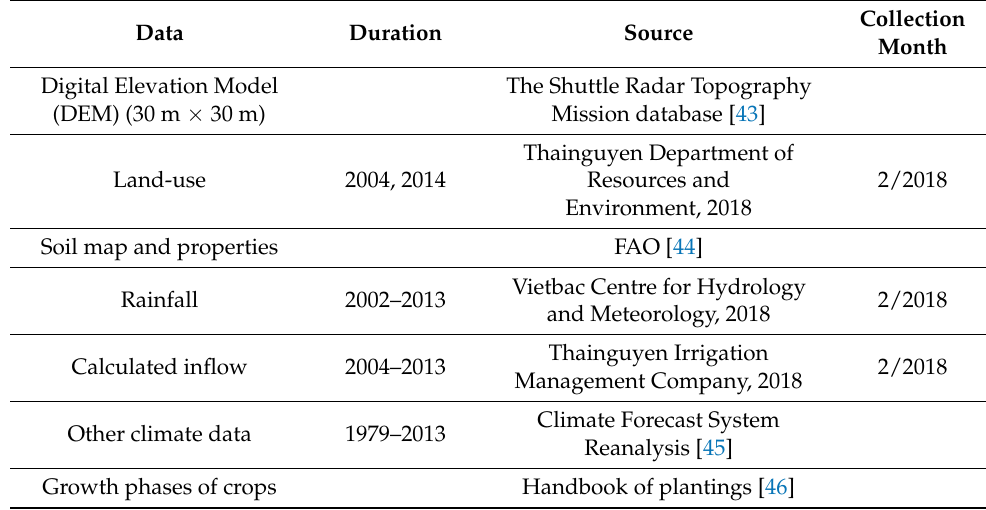
Table 1. Input data for the